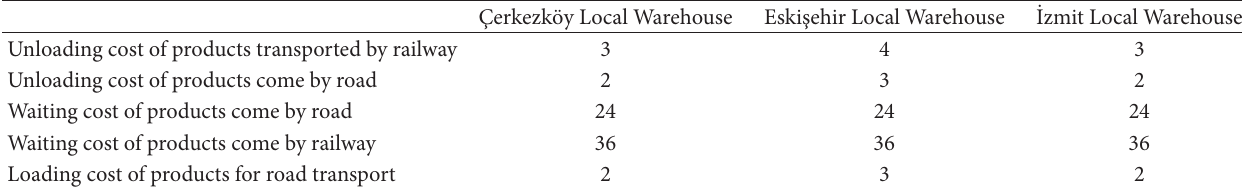
Table 15: Unloading, warehousing, and loading times in local warehouses (hours/container).